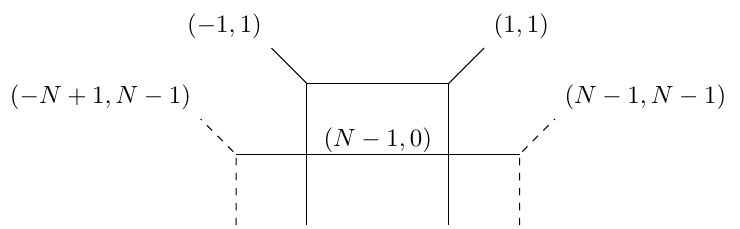
Figure 3 . Y N junction with the central node of the quiver deformation (4.11) partly resolved. The solid lines show the subweb correspobding to the central node; it can be obtained from a + N; 2 web by integrating out two (cid:13)avors. The quiver tails correspond to the dashed lines. The free energy is obtained from (2.29) with (3.17) and (4.7), which